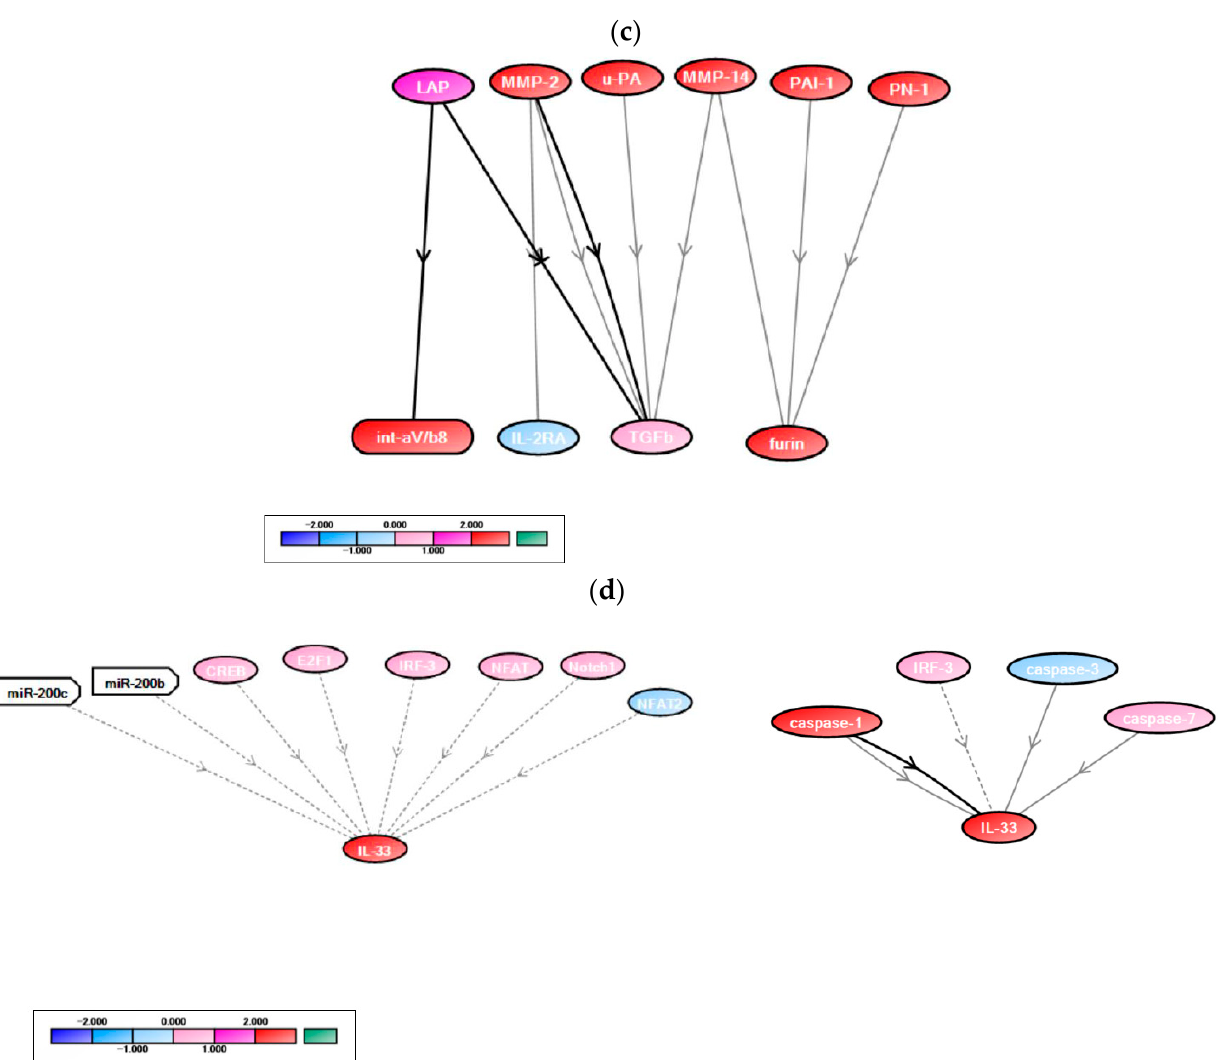
Figure 2. Relationship diagram of genes correlated with FOXP3 in TNBC revealed by network analysis. The solid lines indicate direct regulation, and the dotted lines indirect regulation. Color gradations of ovals indicate the expression level of each gene (left down). ( a ) Specific genes correlated with FOXP3 in TNBC cell lines (MDA-MB-231 and CAL-51). ( b ) Refined regulation relationship of moesin , transforming growth factor beta 2 (TGFB2) , interleukin ( IL ) -33 , CD73 , and MMP2 . ( c ) Refined regulation relationship of TGFB . ( d ) Refined regulation relationship of IL-33.